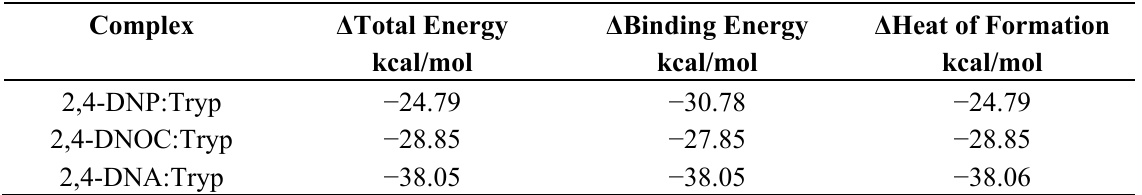
Table 5. Variation of energy complexes PM3.